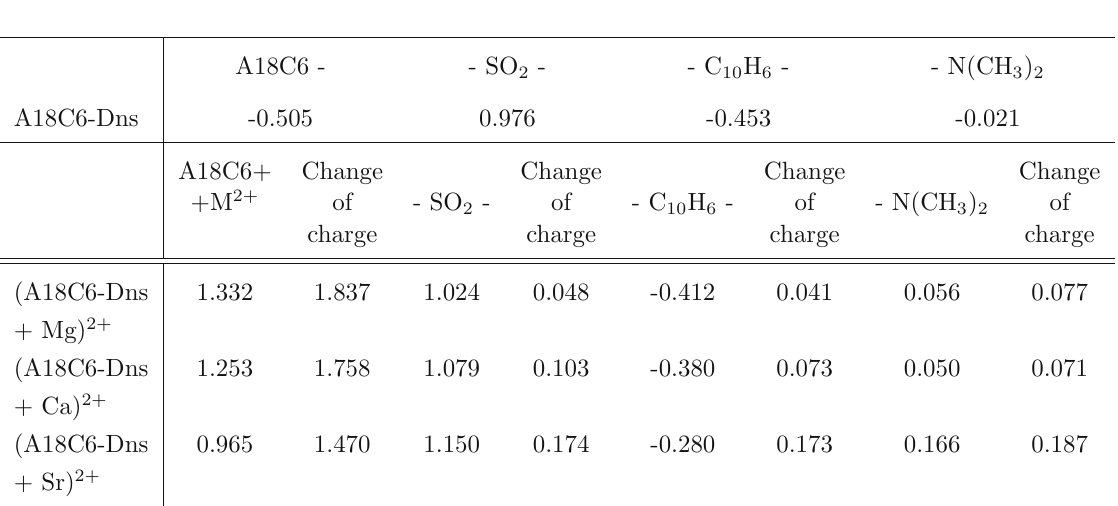
Table 5 Changes in charge distribution of the selected fragments of A18C6-Dans induced by the complex formation. Mulliken changes have been used for the